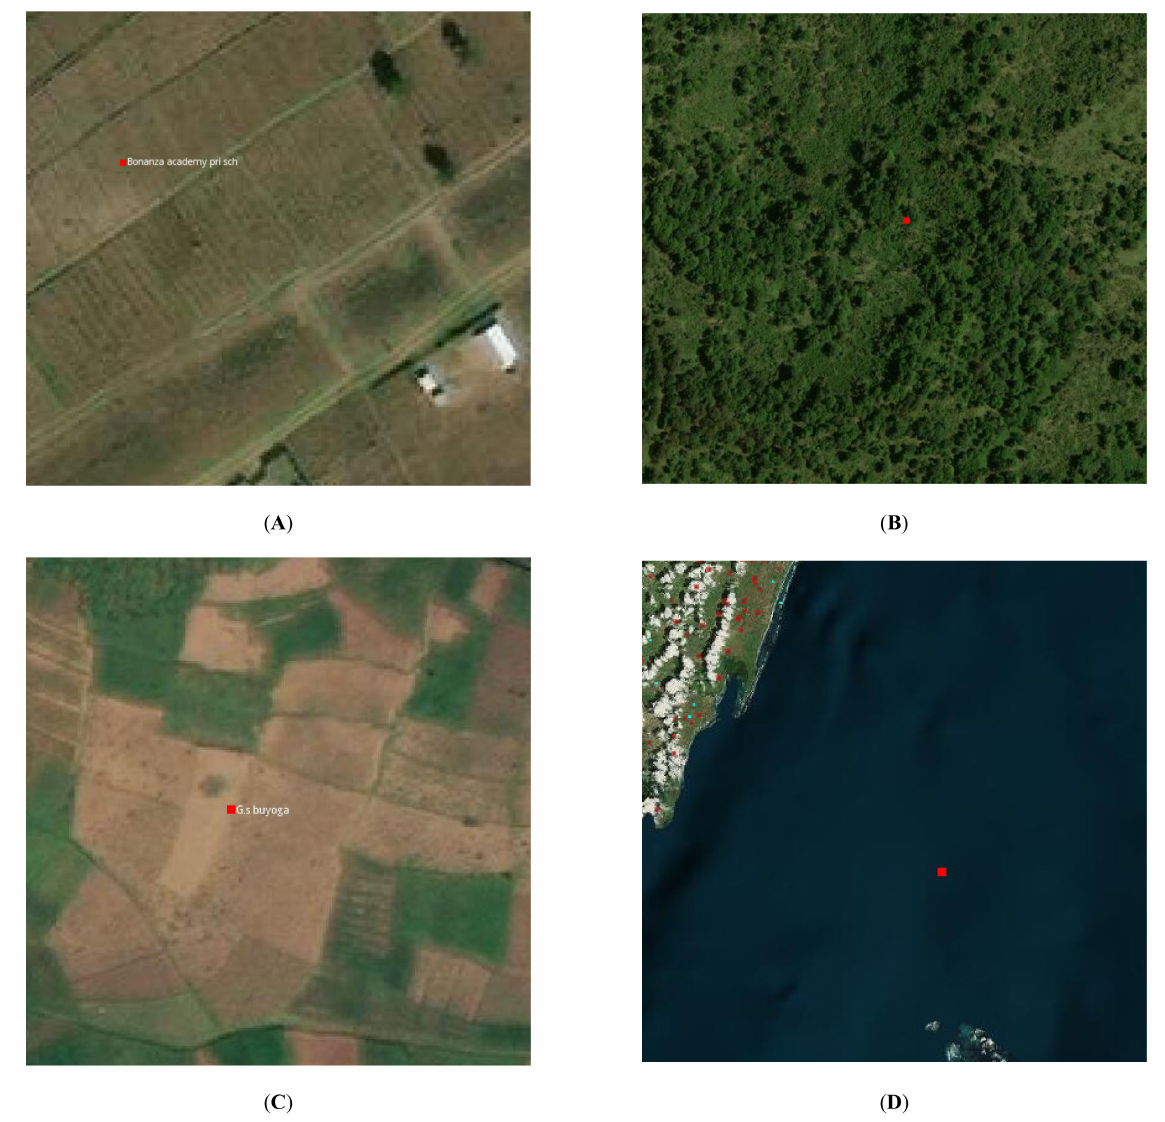
Figure 7. Examples of verified ‘No’ school image tiles. ( A ) School location far from residential areas, ( B ) School location in forest areas, ( C ) School location in farm fields, ( D ) School location in the